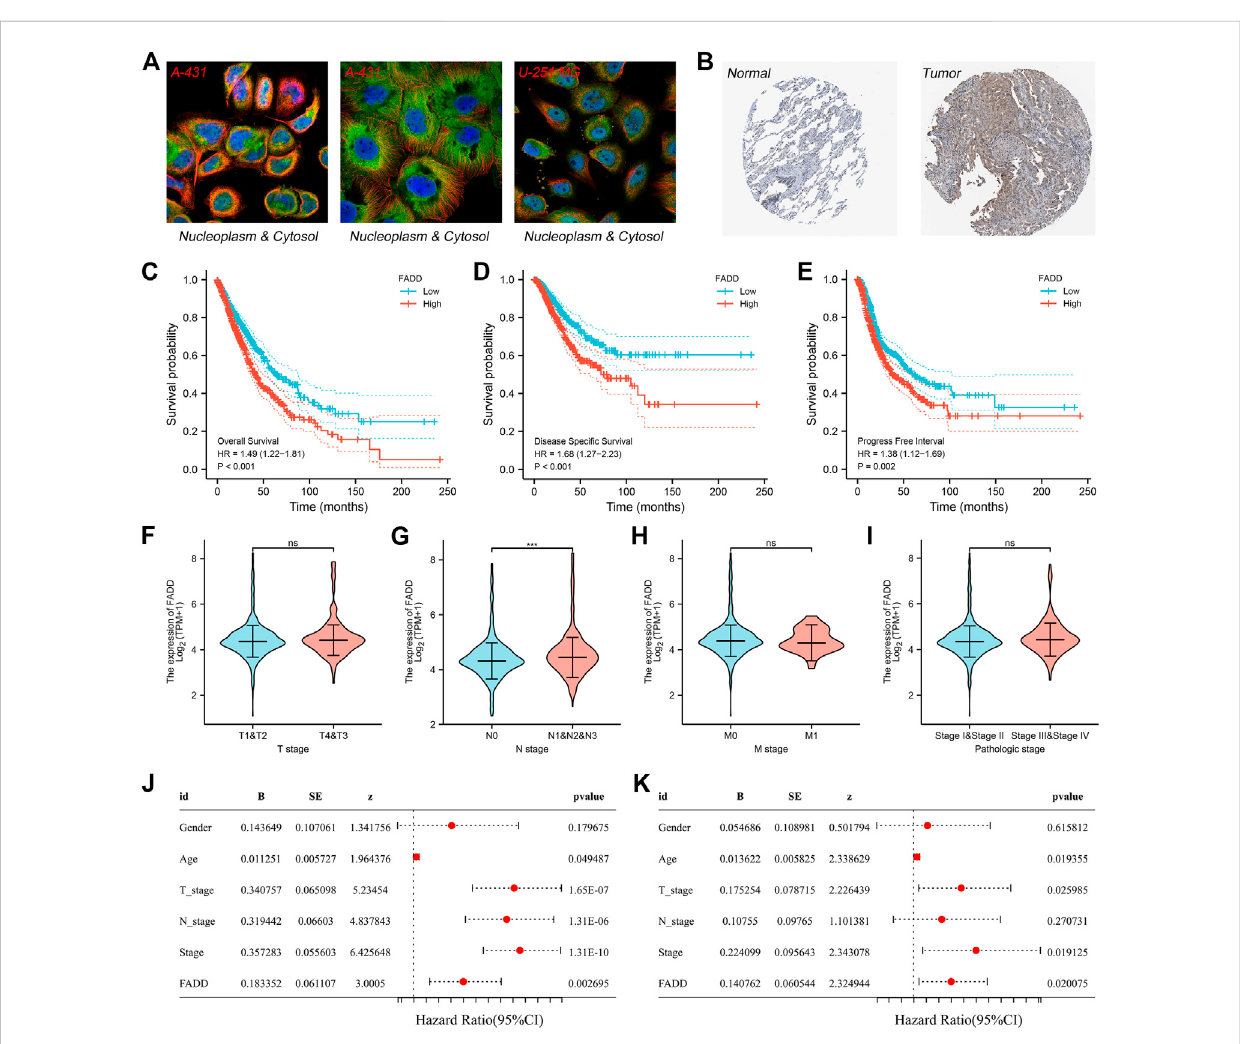
FIGURE 2 ClinicalroleofFADDinlungcancer.Notes: (A) SubcellularlocalizationofFADD; (B) ImmunohistochemistryimageofFADDinlungcancertumorand normal tissue; (C) The OS difference in high- and low-FADD expression patients; (D) The difference in DSS among patients having high and low FADD expression; (E) The difference in PFI among patients having high and low FADD expression; ( F-I) : Clinical correlation of FADD; ( J-K) : Univariate and multivariate analysis of